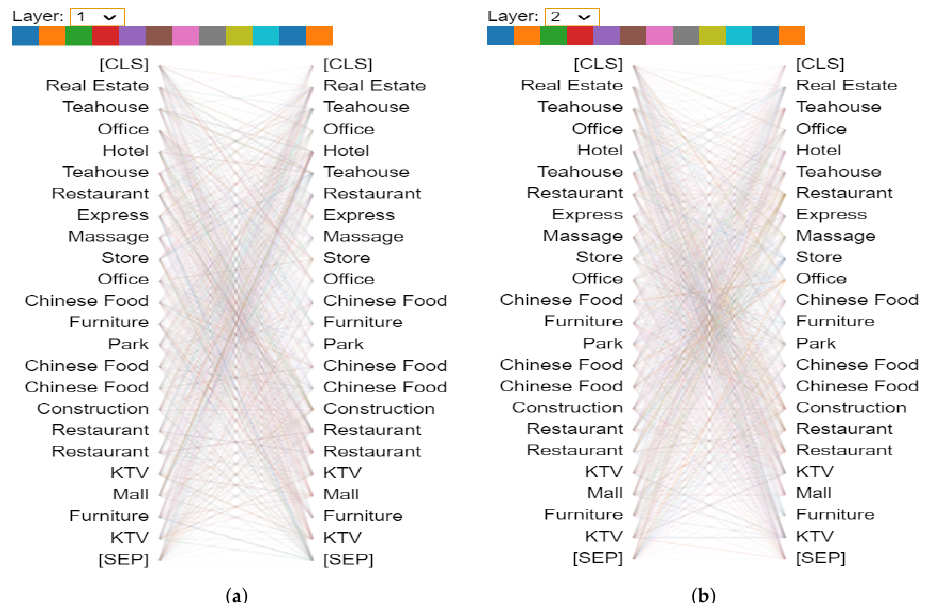
Figure 17. Attention Layer 1 and Layer 2 in GeoBERT-RandomPath. Unlike the above two methods, there were no obvious signs observed. Therefore, we think that no position information has been acquired by GeoBERT-RandomPath. This phenomenon is reasonable since all POIs are ordered randomly: ( a ) Attention Layer 1: ( b ) Attention Layer